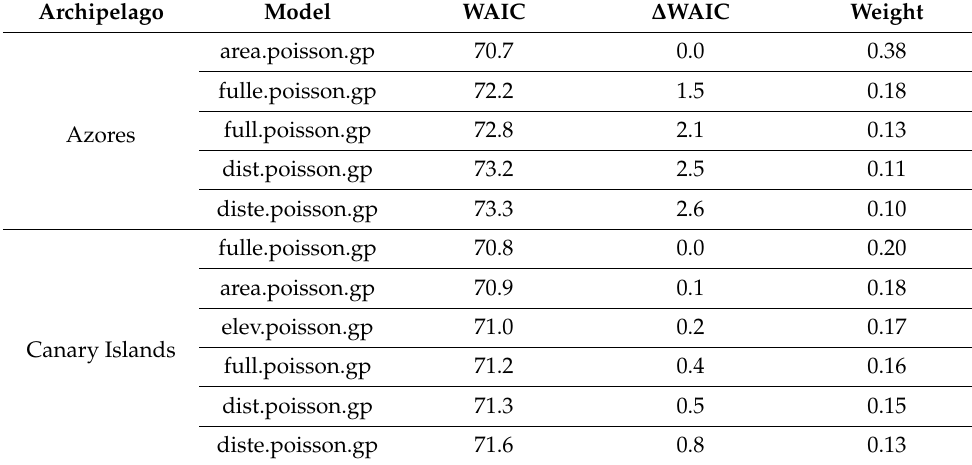
Table 8. Comparison of the several models using the “Widely Applicable Information Criterion” (WAIC) criterion for the endemic species. Only models with ‘weight’ greater than 0.01 are shown. See the captions of Tables 3 and 6 for the explanation of the